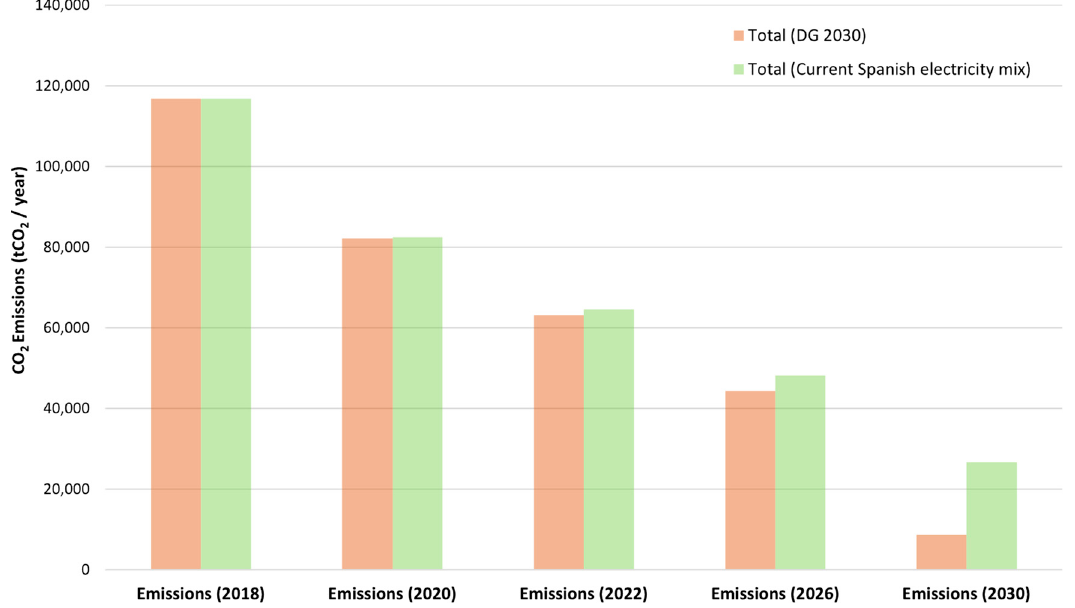
Figure 20. Comparison of the estimated CO 2 emissions between the current Spanish electricity mix and DG2030 scenario.